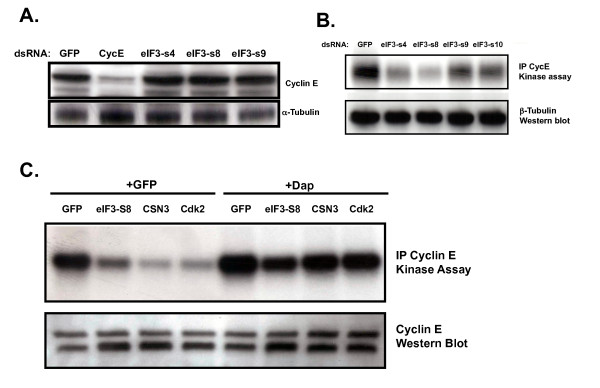
RNAi directed against members of the eIF3 protein complex does not affect Cyclin E expression but does affect Cyclin E-associated kinase activity. (A) Western blot for Cyclin E expression in whole cell extracts from S2R+ cells treated with the indicated dsRNAs. (B) Kinase activity on histone H1 of Cyclin E immunoprecipitates from S2R+ cells treated with the indicated dsRNAs. (C) Kinase activity on histone H1 of Cyclin E immunoprecipitates from S2R+ cells treated with dsRNA targeting the indicated members of the COP9 signalosome, proteasome lid or eIF3 protein complex in combination with either dsRNA targeting GFP or Dacapo.